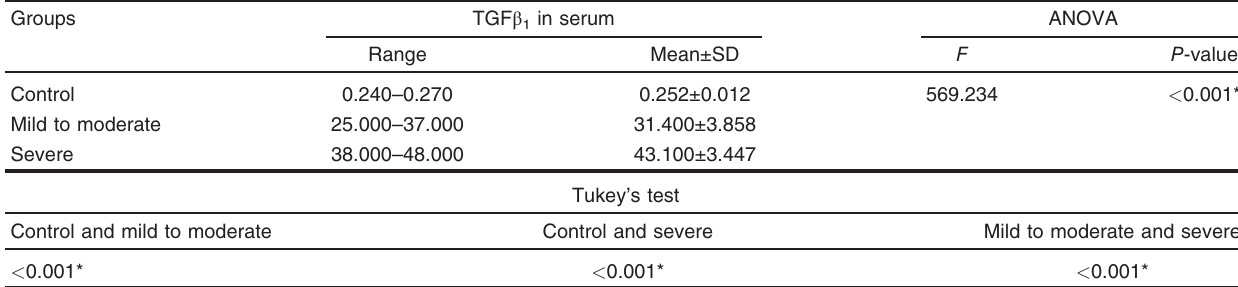
Table 6 Statistical comparison of range, mean±SD values of serum levels of transforming growth factor β 1 (ng/ml) in the three studied groups